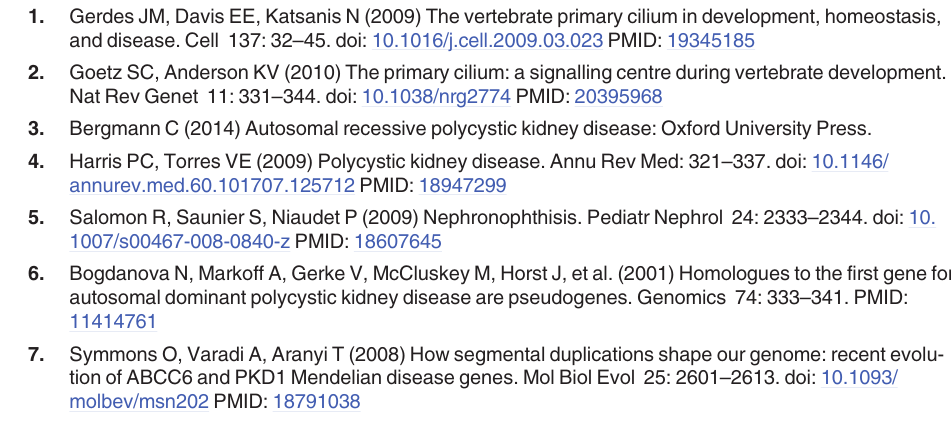
S4 Table. List of all variants included in this study as detected by conventional LR-PCR- Sanger sequencing and by our NGS approach. S5 Table. Sites with discordance between Sanger sequencing and NGS. S6 Table. List of all “ putatively ” pathogenic PKD1 variants previously reported in patients of the validation cohort. S7 Table. List of all variants simulated in the duplicated region of PKD1 . S8 Table. Results from CNV analysis. S9 Table. Coverage statistics for a proof-of-principle ultra-deep sequencing setup for PKD1